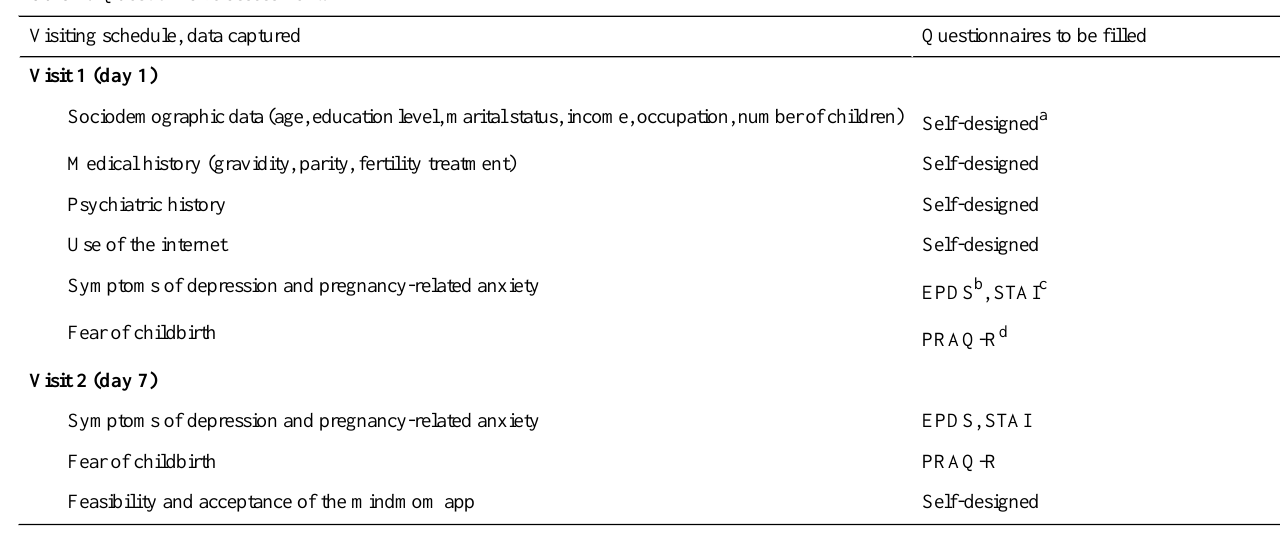
Table 2. Questionnaire